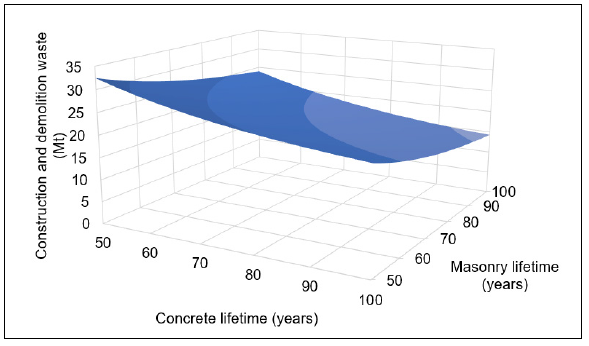
Sensitivity of the material lifetime analysis result to concrete and masonry